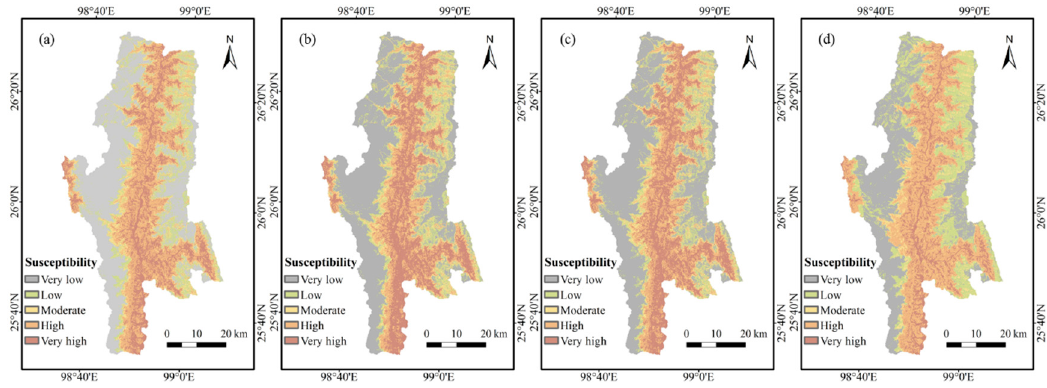
Figure 9. Landslide susceptibility mapping using ( a ) SVM–ANN–NB–LR (SANL), ( b ) SVM–ANN–NB (SAN), ( c ) ANN–NB–LR (ANL), ( d ) SVM–ANN–LR (SAL).